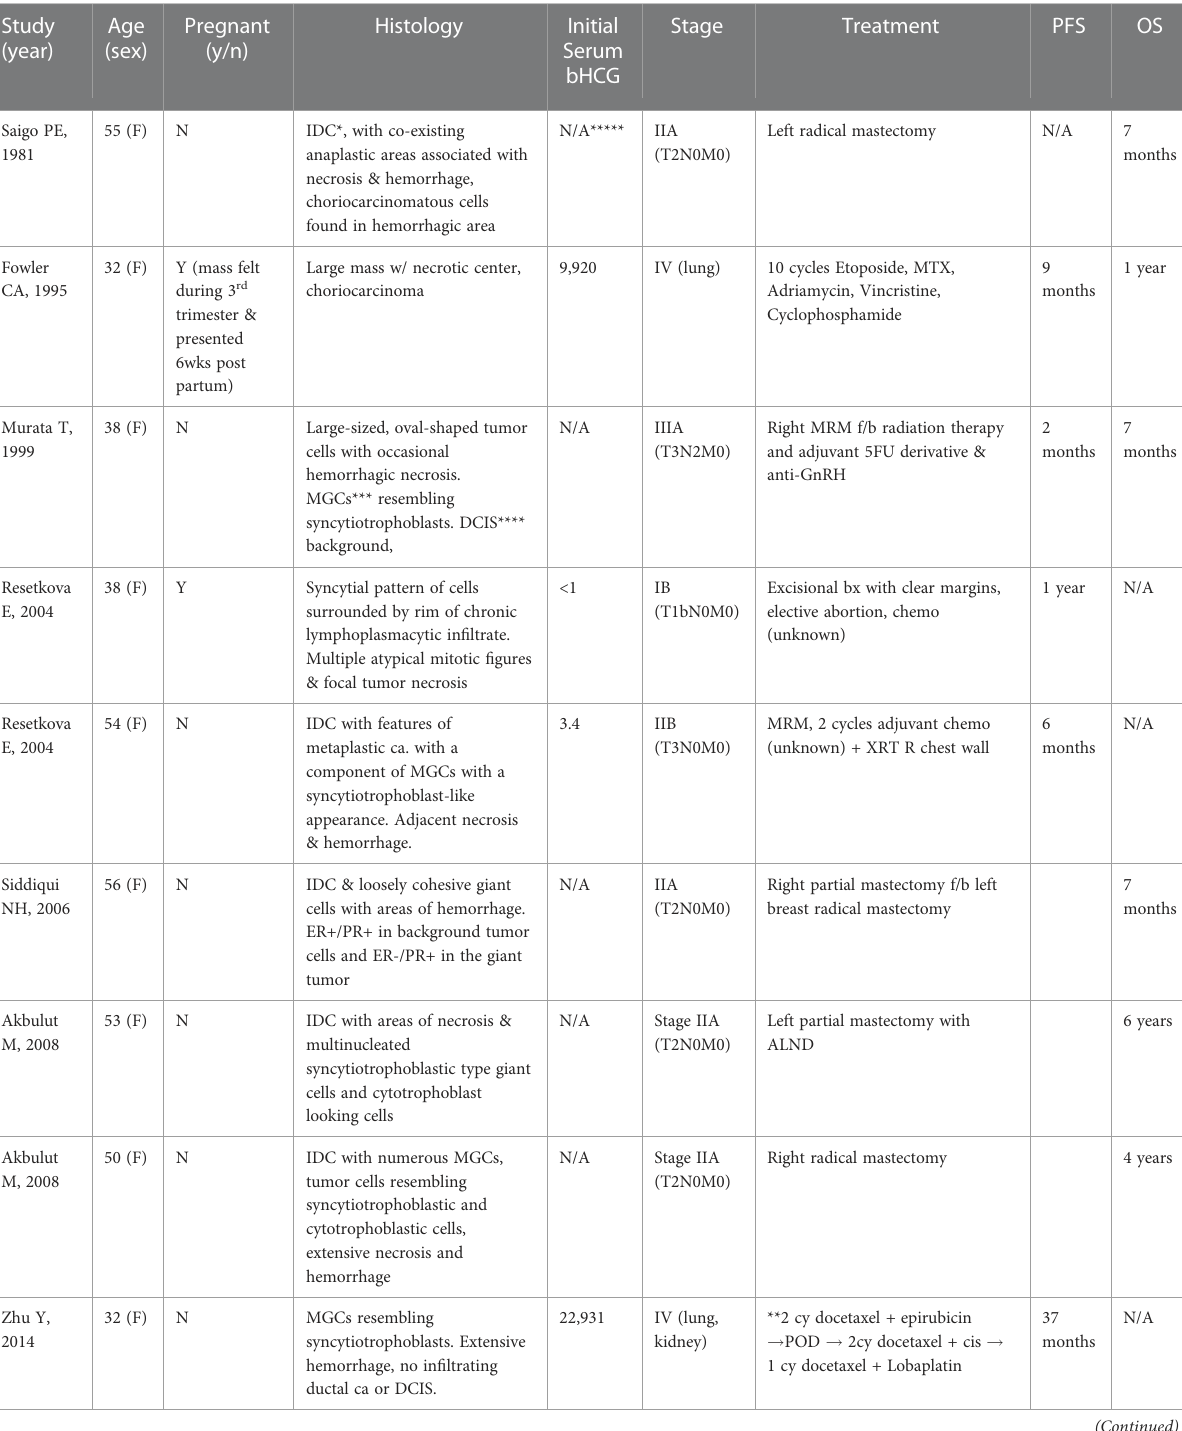
TABLE 1 Previous case reports of BCCF with details of case, treatment and